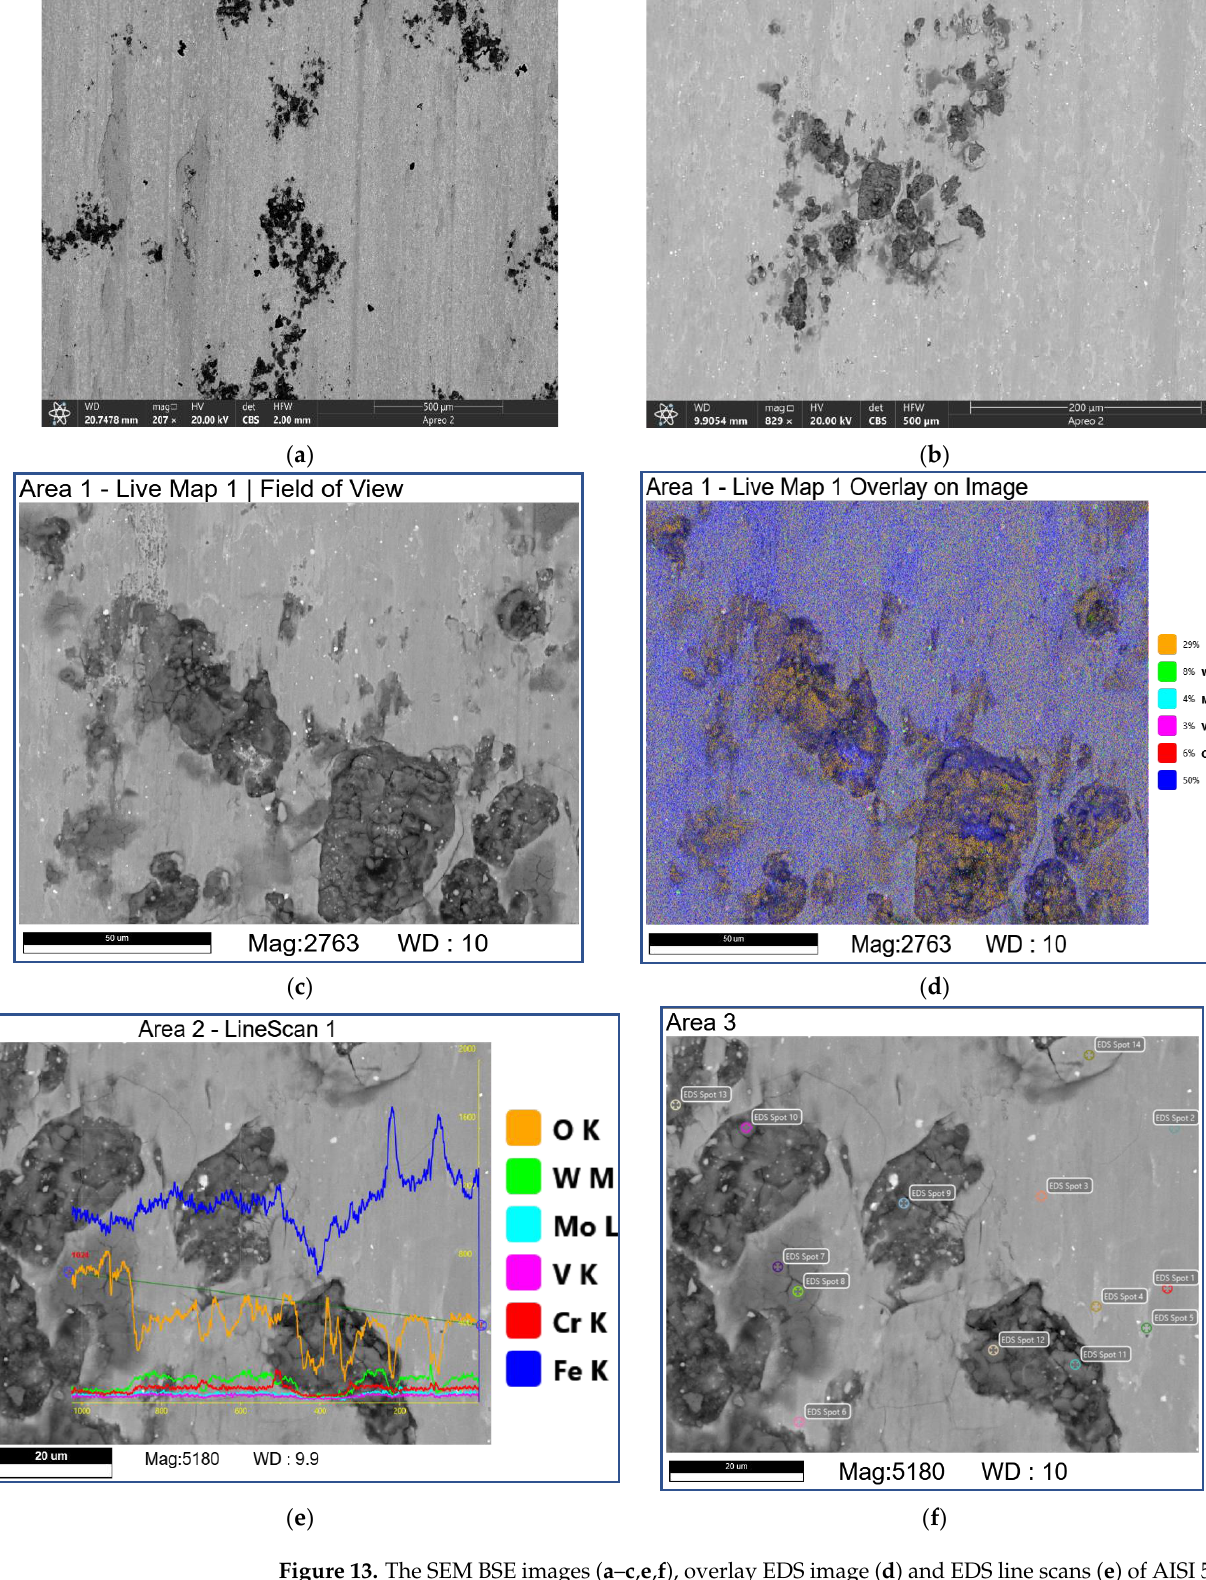
Figure 13. The SEM BSE images ( a – c , e , f ), overlay EDS image ( d ) and EDS line scans ( e ) of AISI 52,100 counterbody worn surface. Data presented for specimens after sliding speed of 3.6 m/s. Numbers on ( f ) indicate probe zones for which EDS elemental concentrations were determined indicated